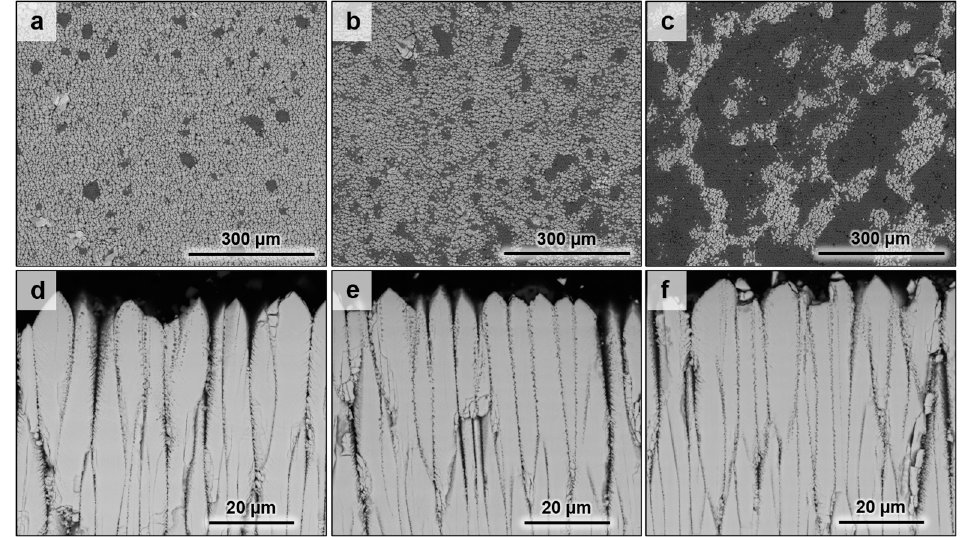
Figure 3. SEM micrographs of the standard 8YSZ coating with calcium–magnesium–aluminium silicates (CMAS) deposits of ( a , d ) 0.25 mg·cm − 2 , ( b , e ) 1 mg·cm − 2 , and ( c , f ) 5 mg·cm − 2 annealed in air at 1250 °C for 1 h.